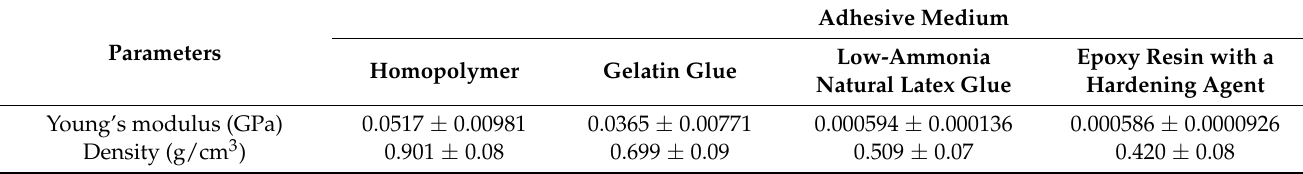
Table 4. Value of the Young’s moduli and density of the produced composite materials (average values).